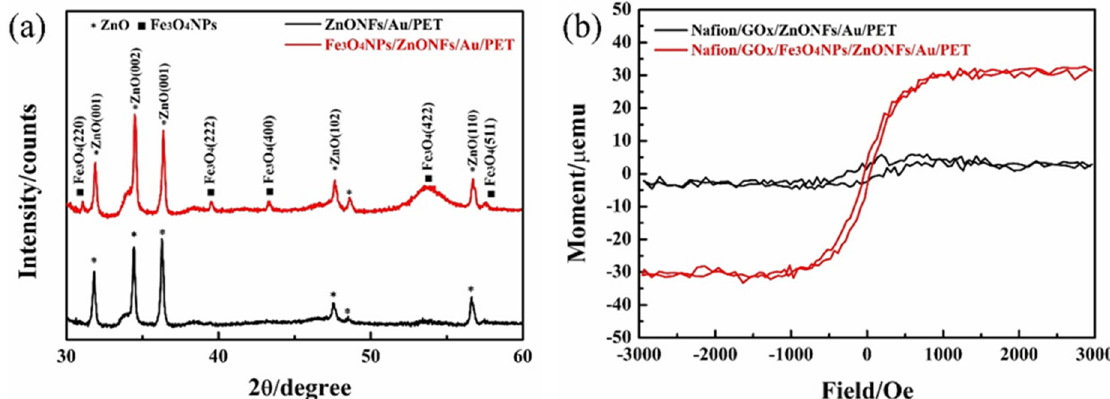
Figure 3. ( a ) XRD curves of ZnONFs/Au/PET and Fe 3 O 4 MNPs/ZnONFs/Au/PET substrates. ( b ) Magnetic hysteresis loops behavior of ZnONFs/Au/PET and Fe 3 O 4 MNPs/ZnONFs/Au/PET.